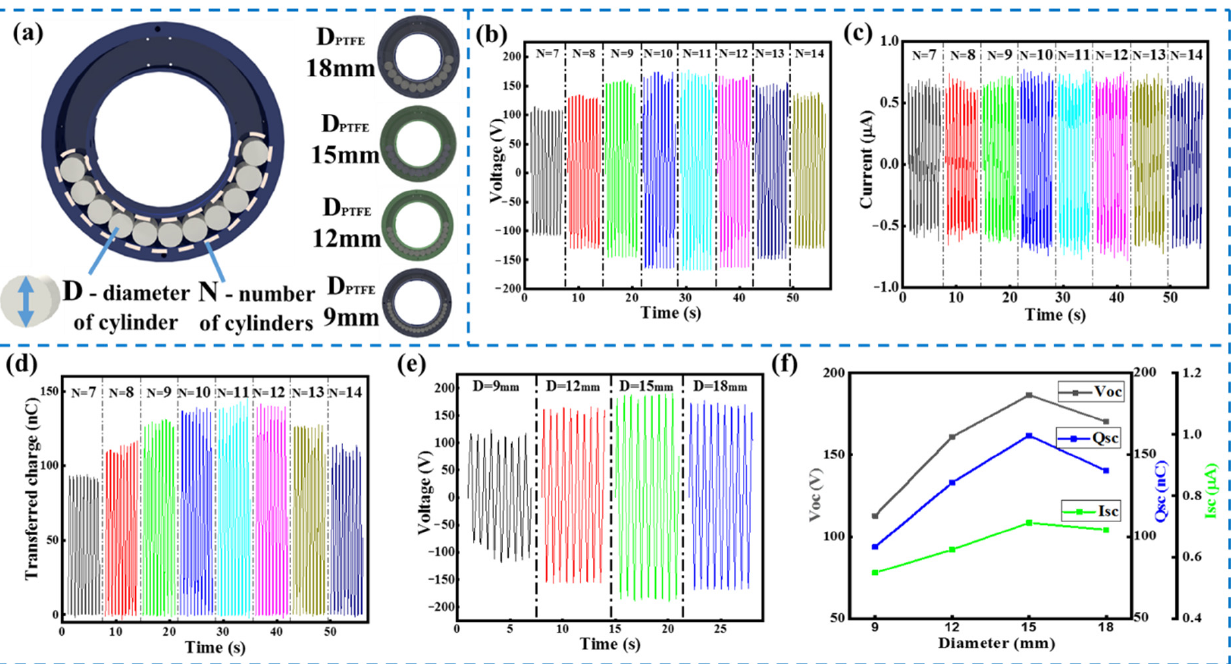
Figure 3. Electrical output of the R-TENG: ( a ) schematic illustration of structural parameters of the R-TENG; ( b ) output voltage; ( c ) current and ( d ) transferred charge of the R-TENG with the increasing number of cylinders generated at 100 rpm; ( e ) output voltage of R-TENG with PTFE cylinders of different diameters; ( f ) trend chart of the electrical performance of the R-TENG with cylinders of different diameters at 100 rpm.